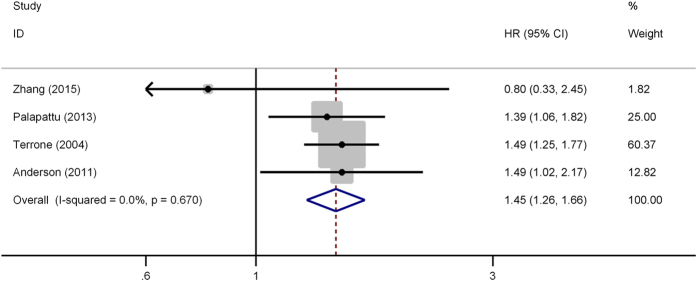
Forest plot of studies evaluating the association between urinary collecting system invasion and overall survival of renal cell carcinoma.HR = hazard ratio; CI = confidence interval.